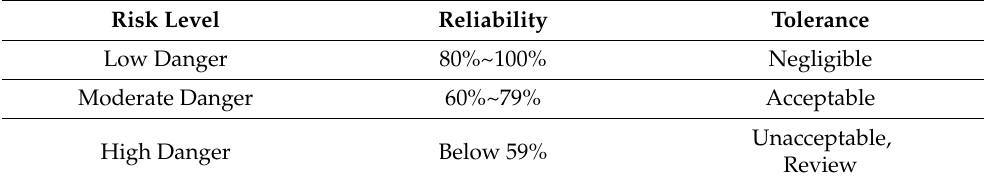
Table 1. Tolerable risk level.